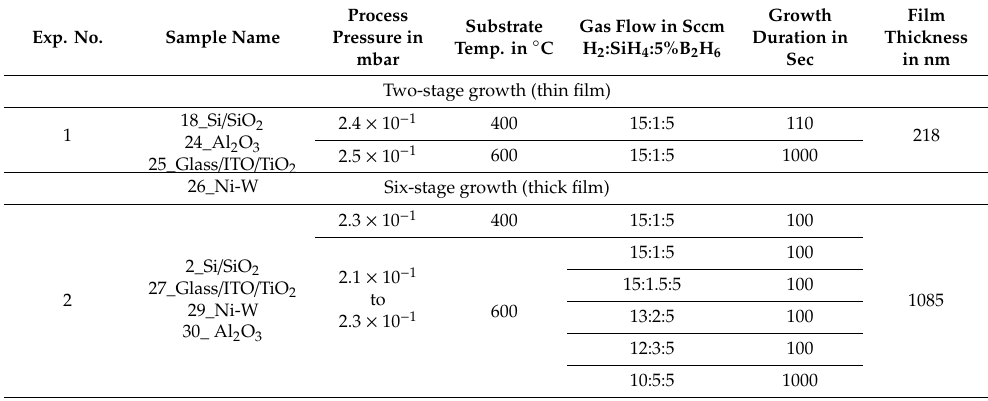
Table 1. Growth parameter of boron-doped p-type polycrystalline silicon films on Si / SiO 2 , sapphire (Al 2 O 3 ), glass / ITO / TiO 2 , and Ni-W